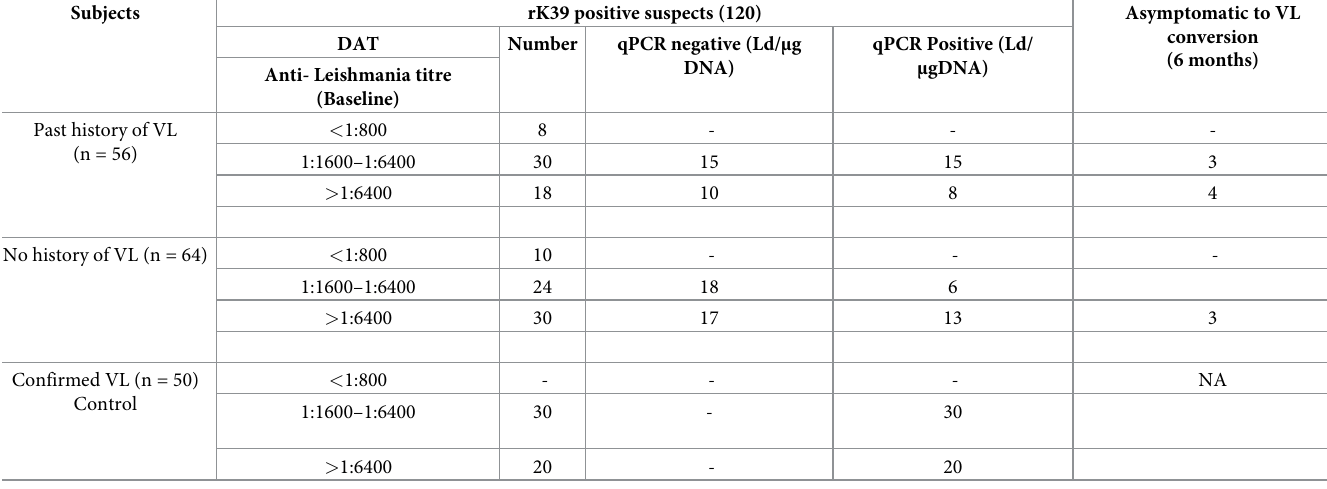
Table 1. Development of endemic healthy control into symptomatic VL at the end of 6 month follow up (rK39, DAT and qPCR analysis). Subjects